Question: Which visualization type does this figure use?
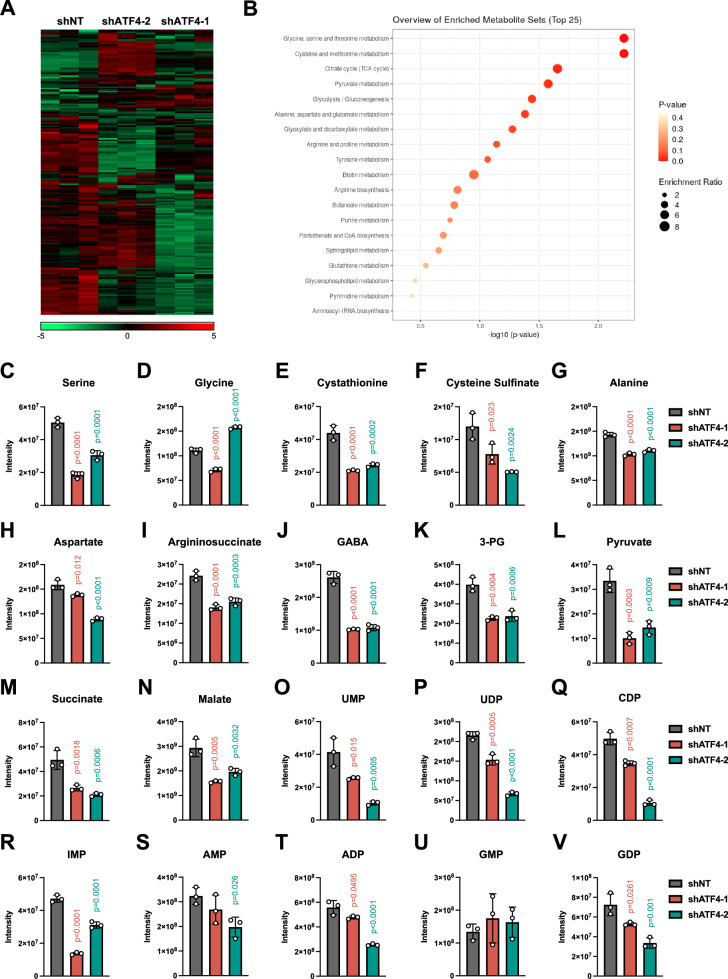
Answer: heatmap